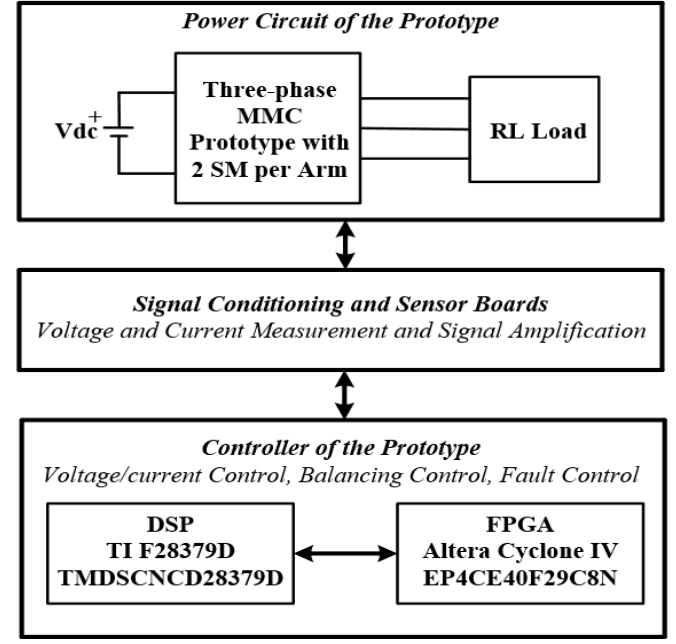
Figure 10. An illustration of the test-setup.